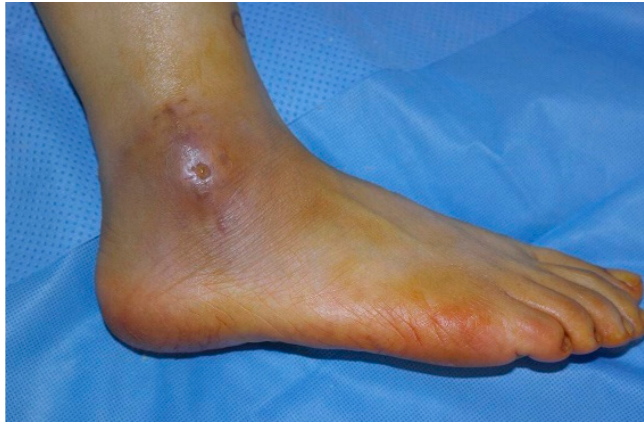
Figure 2. C yst with an open skin wound. Figure 2. Cyst with an open skin